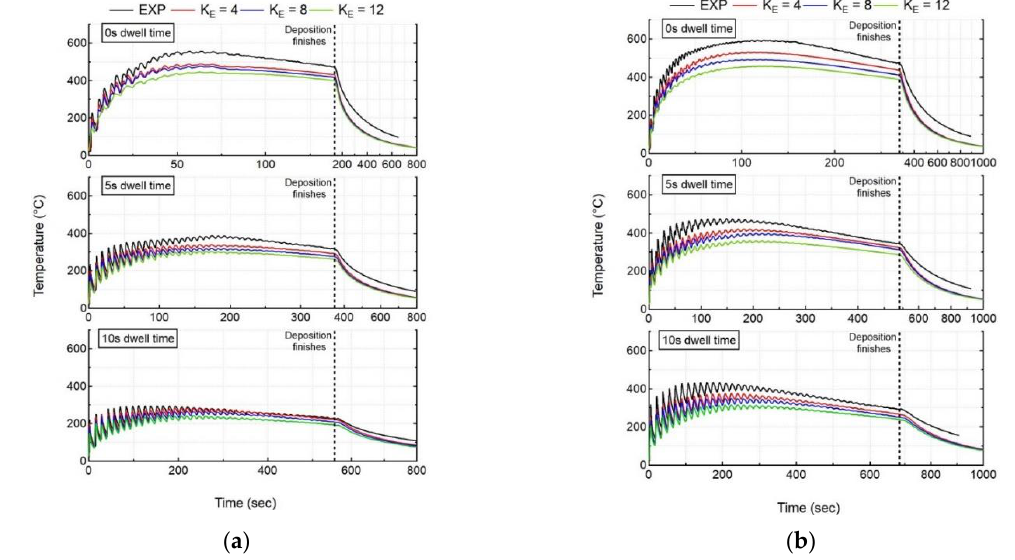
Figure 10. Comparison of numerical results using the elongated ellipsoid (EE) with recorded in situ thermal history of thermocouple 1 for all cases ( a ) single-bead wall, ( b ) double-bead wall.